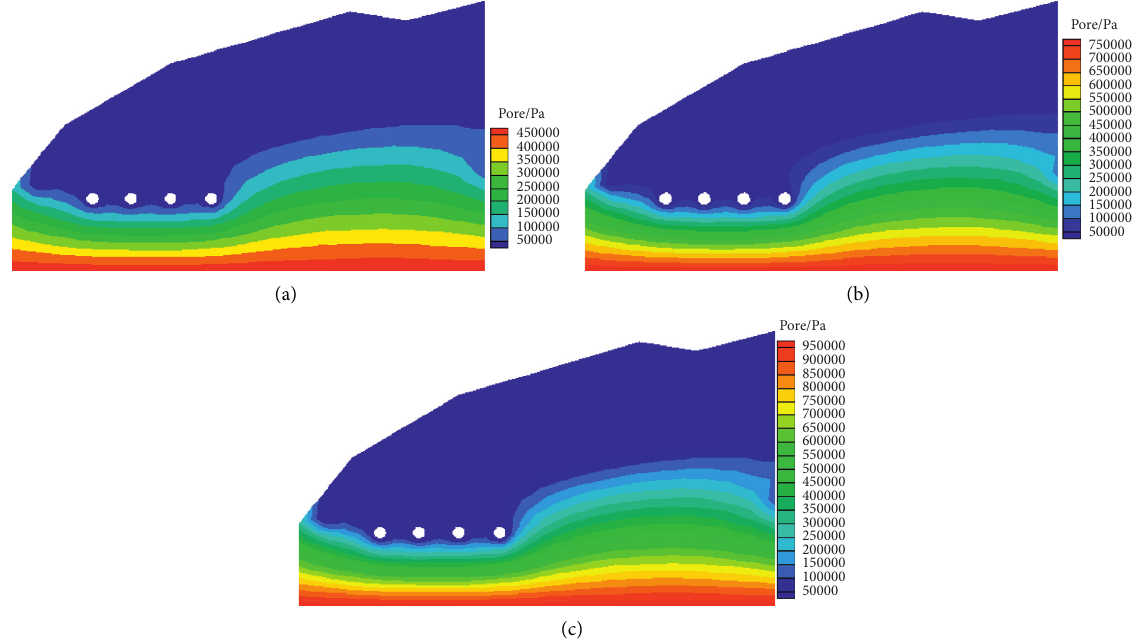
Figure 15: The pore water pressure nephogram under different hydraulic heads. (a) Hydraulic head (H) s � 50 m. (b) Hydraulic head (H) s � 80m. (c) Hydraulic head (H) s � 100m.